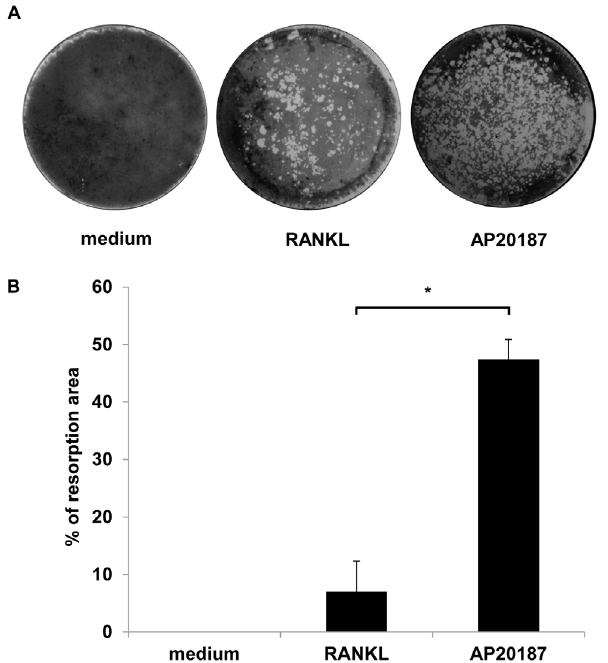
Figure 6. CID induced osteoclasts resorbed a two-dimensional mineralized substrate. (A) RAW264.7 + iRANK cells were treated with either RANKL (100 ng/ml) or AP20187 (100 nM) on Osteologic discs. After 10 days, resorption lacunae were visualized by von Kossa staining. (B) The percent resorbed area per disc was measured and analyzed using ImageJ. Three experiments were averaged. Y-axis shows the % resorption per disc. *p , 0.05.